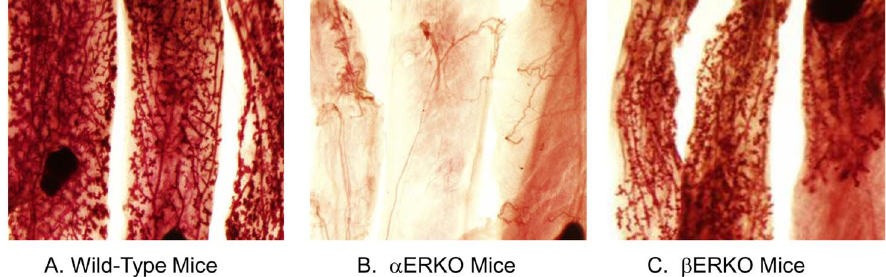
Figure 1. Effects of pretreatment with estradiol and progesterone on the mammary gland development in MMOC. WT, a ERKO and b ERKO mice were treated with 1 m g estradiol and 1 mg Progesterone subcutaneously for 9 days. The thoracic pairs of glands were dissected and cultured in serum free Weymouth’s medium for 10 days in the presence of insulin (1 m g/ml), prolactin (5 m g/ml), aldosterone (1 m g/ml) and hydrocortisone (1 m g/ml). Results show that a ERKO mice pretreated with E and P do not respond to hormones, no ductal expansion or alveolar development is observed (panel B), whereas WT and b ERKO mice respond to E plus P treatment and to hormones in MMOC.